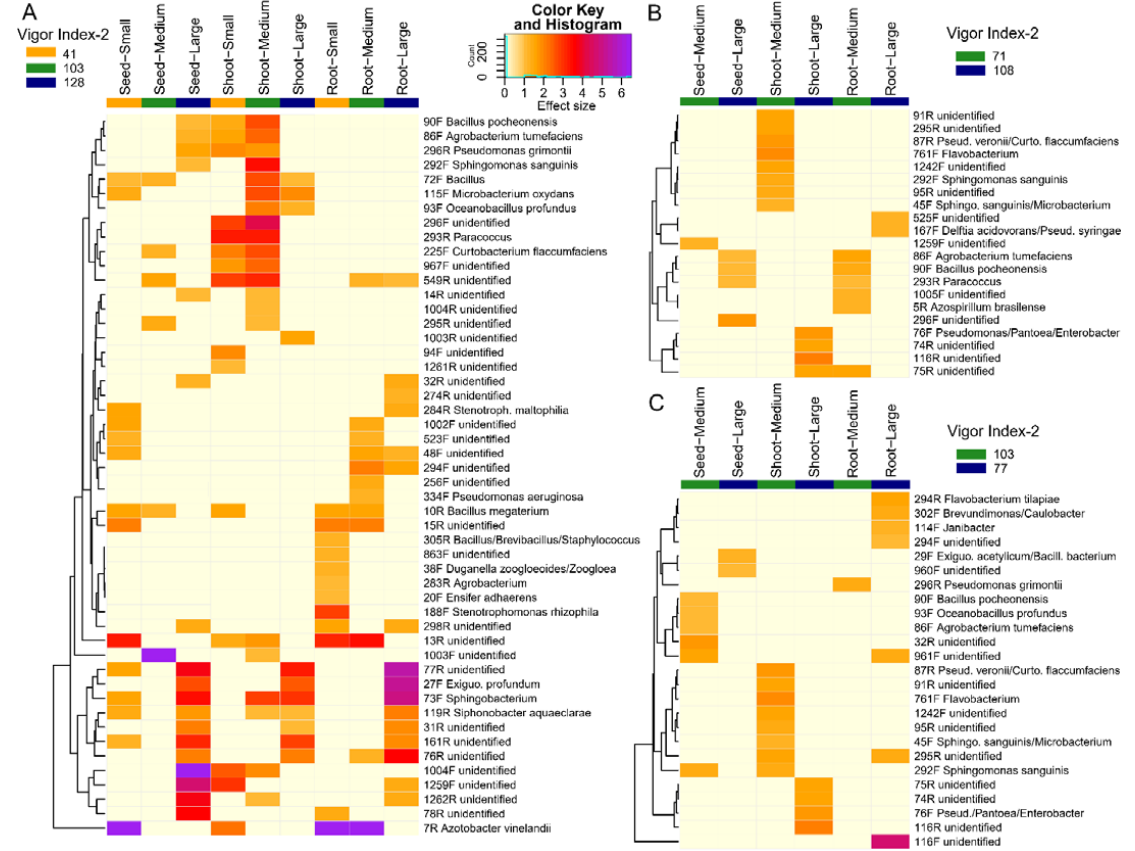
Figure 5. Heatmap of high effect (ALDEx) TRFs alongside probable taxonomic identities. TRFs of each seed category along with their respective tissue types (seed, shoot and root) and vigor index-2 values. The color gradient displays the strength of the ALDEx effect sizes, higher effect sizes indicate greater differences in TRF intensity between sample types. Variety 1 ( A ), Variety 2 ( B ), Variety 3 ( C ).